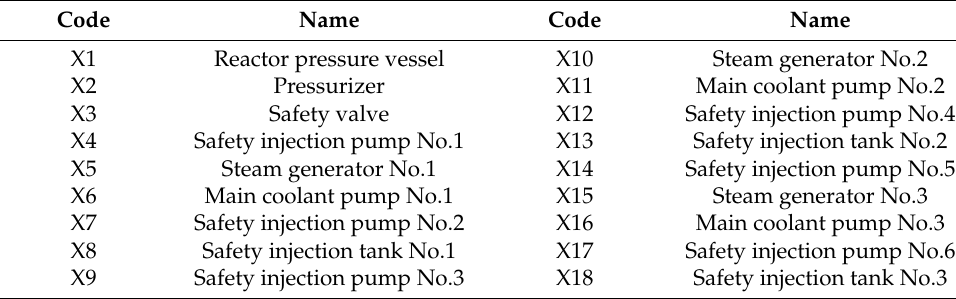
Table 2. Major components of the